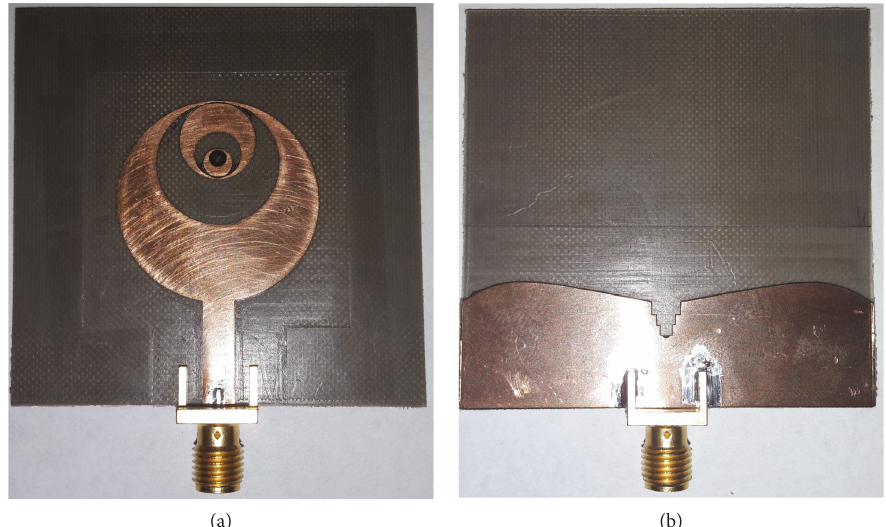
Figure 9: Antenna prototype: (a) front view and (b) back view.